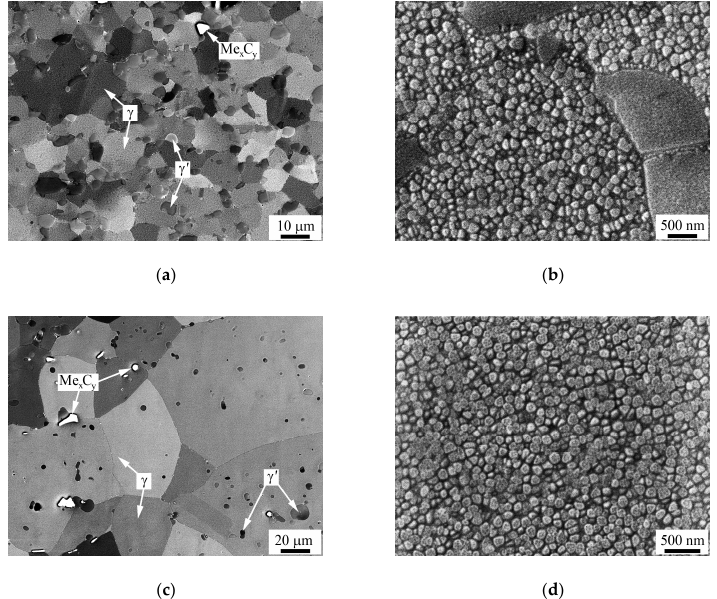
Figure 3. The microstructure images of the superalloy after hot forging, solid solution treatment at different temperatures and ageing: ( a , b ) condition 3, ( c , d ) condition 4. ( a , c ) The arrows show the γ grains, primary γ ′ phase, and carbides (BSE), ( b , d ) γ ′ precipitates (SE).